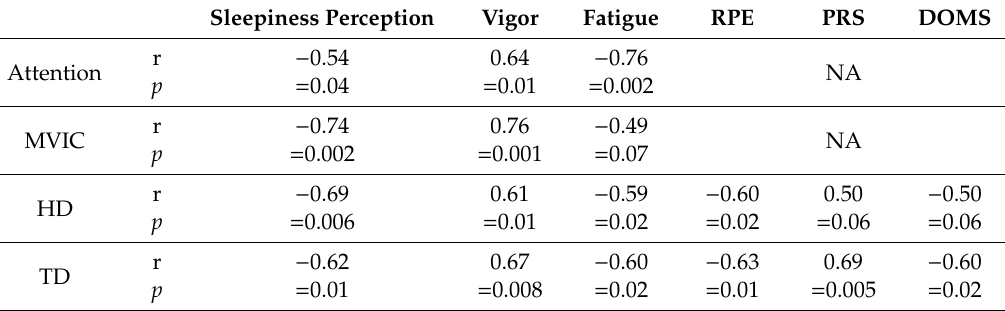
Table 5. Correlations between selected parameters for changes between N40 and N0.